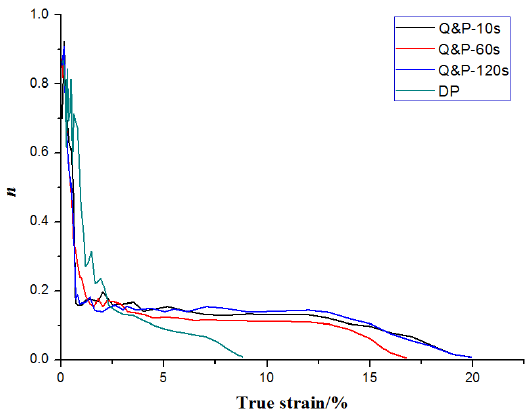
Figure 6. The room temperature tensile engineering.